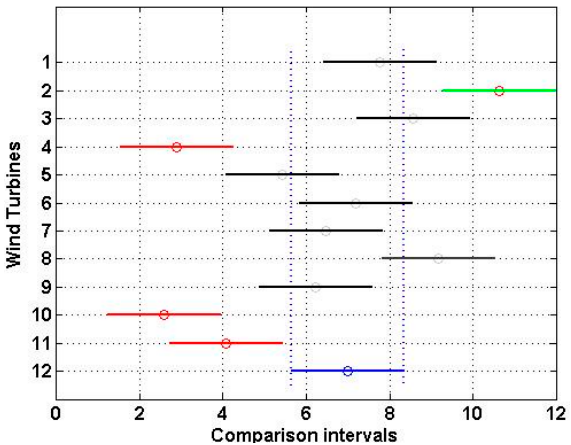
Figure 6. Multiple comparison of the power performance of the wind turbines at the α = 0.05 significance level. WT1: Wind Turbine 1 (Black); WT2: Wind Turbine 2 (Green); WT3: Wind Turbine 3 (Black); WT4: Wind Turbine 4 (Red); WT5: Wind Turbine 5 (Black); WT6: Wind Turbine 6 (Black); WT7: Wind Turbine 7 (Black); WT8: Wind Turbine 8 (Black); WT9: Wind Turbine 9 (Black); WT10: Wind Turbine 10 (Red); WT11: Wind Turbine 11 (Red); WT12: Guaranteed Power Curve (Blue).